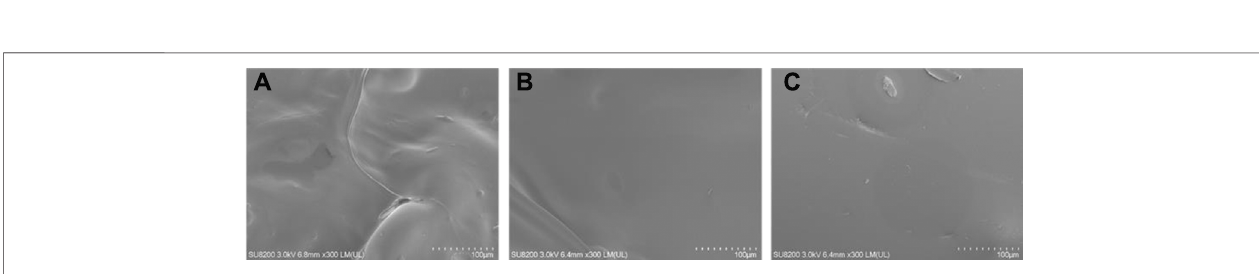
FIGURE 10 | SEM fi gures of char residue (A) coating-1 (B) coating-4 (C) coating-5.